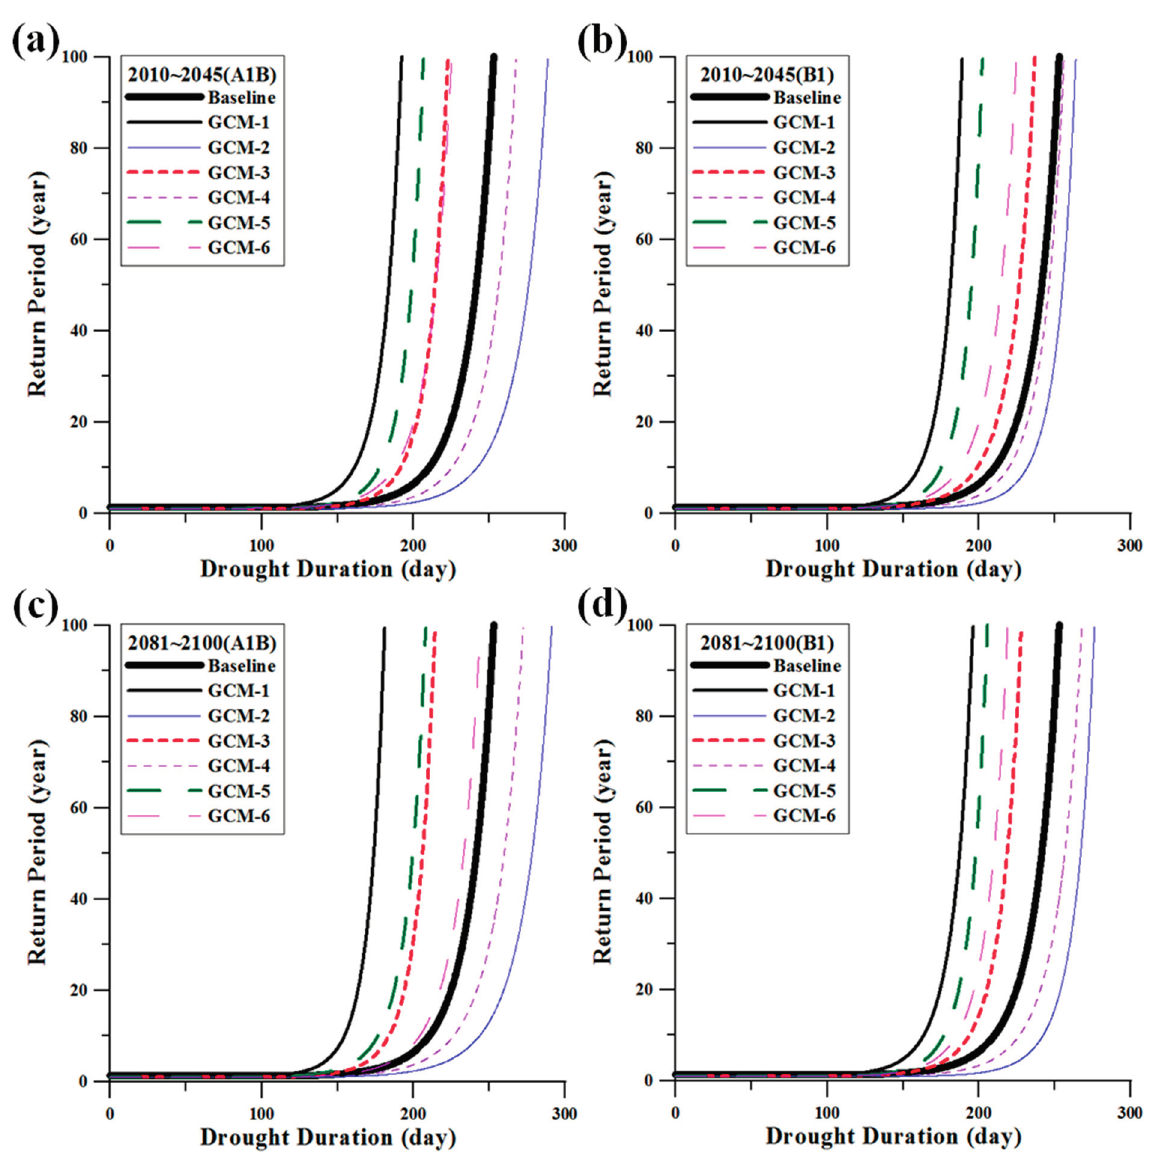
Figure 10. The probability distributions of drought duration for different GCMs, ( a ) during 2010–2045 under A1B scenario, ( b ) during 2010–2045 under B1 scenario, ( c )